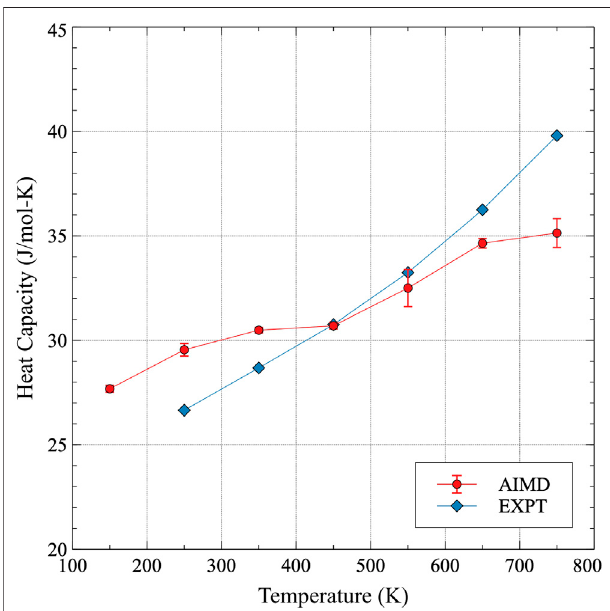
FIGURE 5 | The constant pressure heat capacity of α -U from 100 to 800 K. Results from this work are compared to experimental results from Konings and Benes (2010). Error bars indicate twice the standard error of the AIMD dataset.